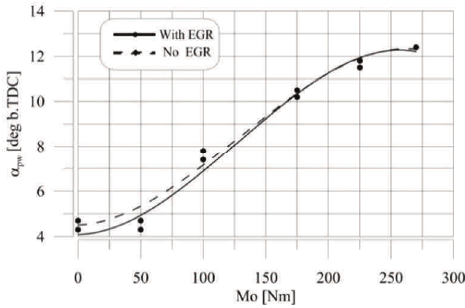
Fig. 9. Influence of the engine load on start of injection a pw for engine operating with/without EGR